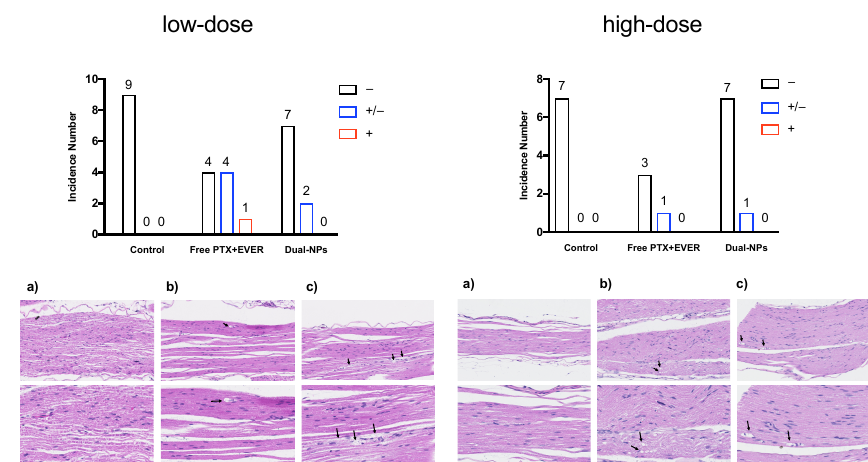
Figure 5. Degenerating myelinated nerve fibers (arrow) were examined in the sciatic nerve after staining with haematoxylin and eosin (H & E) two to three days after weekly injections for six weeks with saline ( a ), dual-targeted PTX + EVER-loaded nanoparticles (Dual-NPs) ( b ), and Free paclitaxel and everolimus (PTX + EVER) ( c ) at a PTX-equivalent dose of 8 mg / kg (left panel) or 15 mg / kg (right panel). Magnification, 20X (upper) and 40X (lower). A semi-quantitative scoring system was used in the evaluation of histologic sections of the sciatic nerve blinded as to the group. The scoring system addresses degenerative changes to myelinated nerve fibers (axonal swelling and vesicular degeneration). Several histologic sections, cut in a longitudinal plane, were examined from each sample. As previously described [16], the degenerating myelinated fiber score was defined as follows: –, no degenerative changes; +/−, very slight degree of degenerative changes (scattered, single fibers affected); +, slight degree of degenerative changes (scattered small groups of degenerative myelinated fibers).